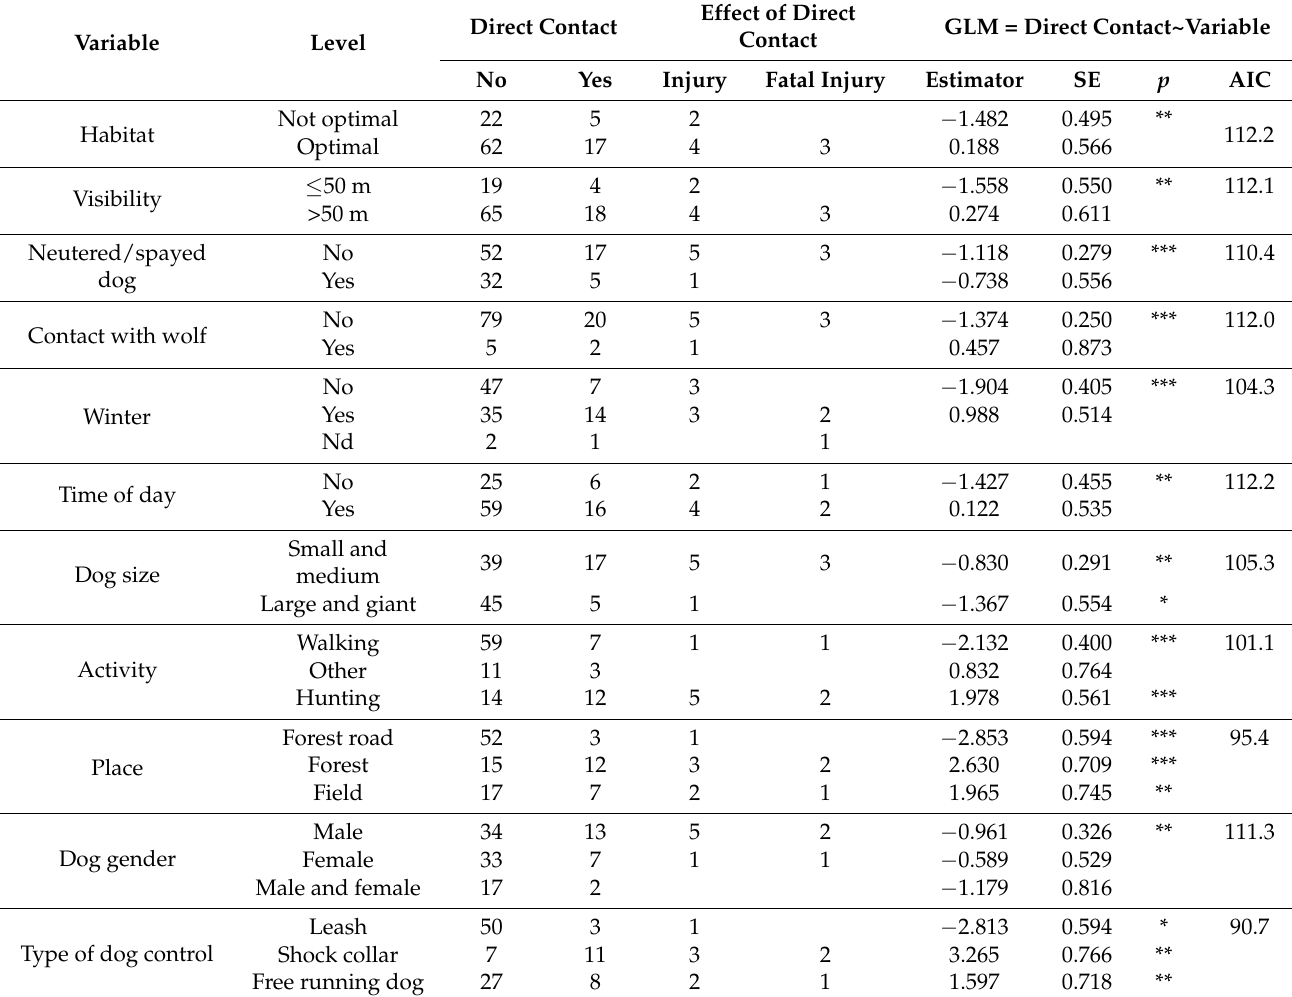
Table 2. Descriptive statistics of binary and ranked data and GLM (family = binomial) results of parameters estimated to explain the occurrence of dog–wolf interactions (models with one explanatory